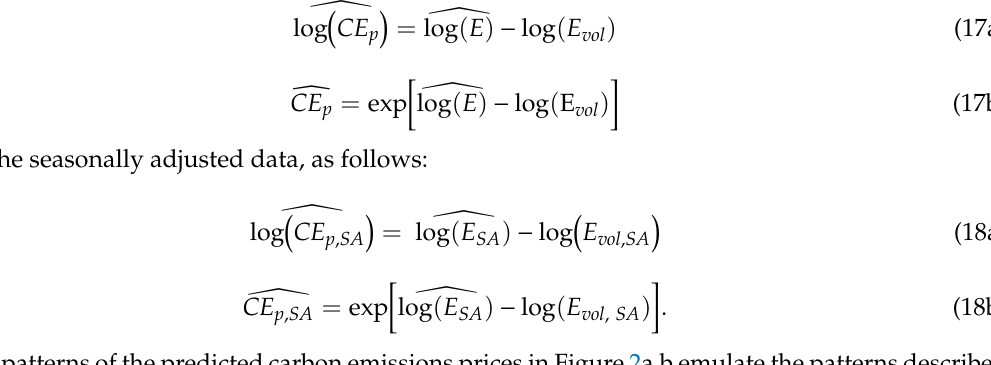
Table 7. Correlation between predicted carbon emissions price and predicted carbon emissions price (SA).